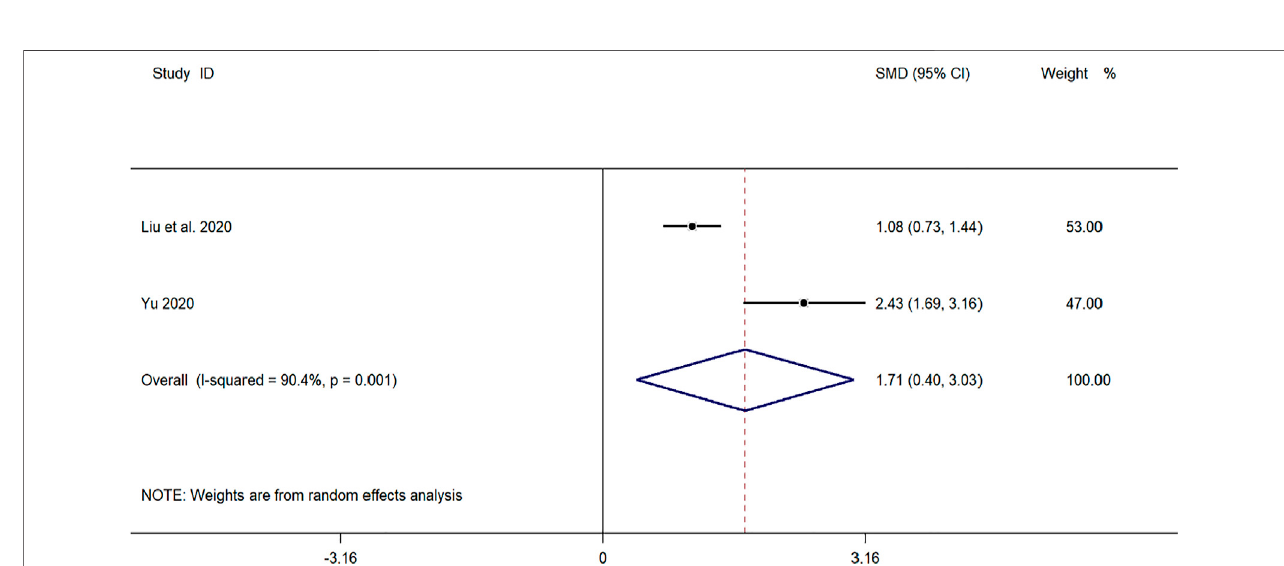
FIGURE 9 | Meta-analysis of forest plots comparing CD4 + cell levels in the experimental and control group.